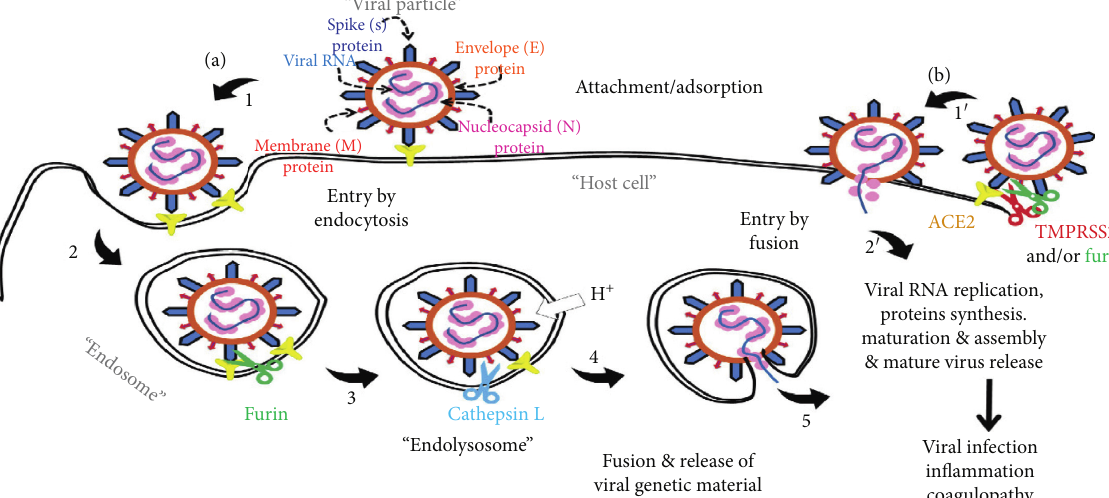
Figure 2: SARS-CoV-2 host cell entry. Entry begins with S protein binding to the host cell ACE2 receptor. (a) Endocytosis-mediated entry entails S protein priming/activation reactions occurring in the endosome/endolysosome. (b) Direct fusion entry is mediated by furin and/or TMPRSS-2 as well as other trypsin-like proteases. Taken from Al-Horani, R. A., Kar, S., and Aliter, K. F., Int. J. Mol. Sci., vol 21 (15), 5224,